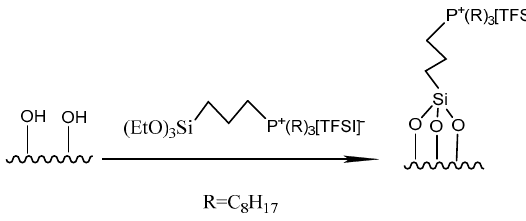
Figure 1. Illustration of synthesizing (EtO) 3 Si[P 8883 ]TFSI ionic liquid-modified silica.